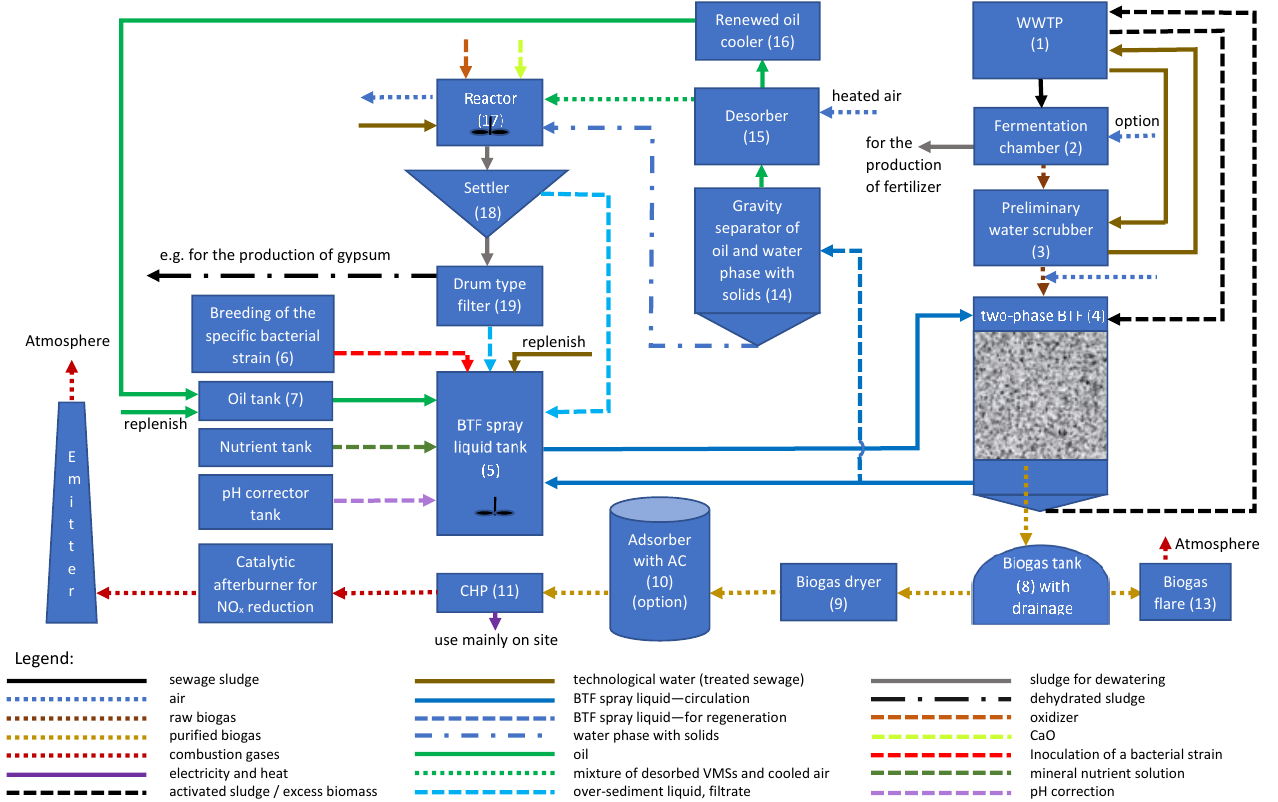
Figure 1. Schematic diagram of the concept of the regenerative biological method for the integrated removal of H 2 S and VMSs from biogas generated from sewage sludge, along with the management of biogas and by-products of the process.